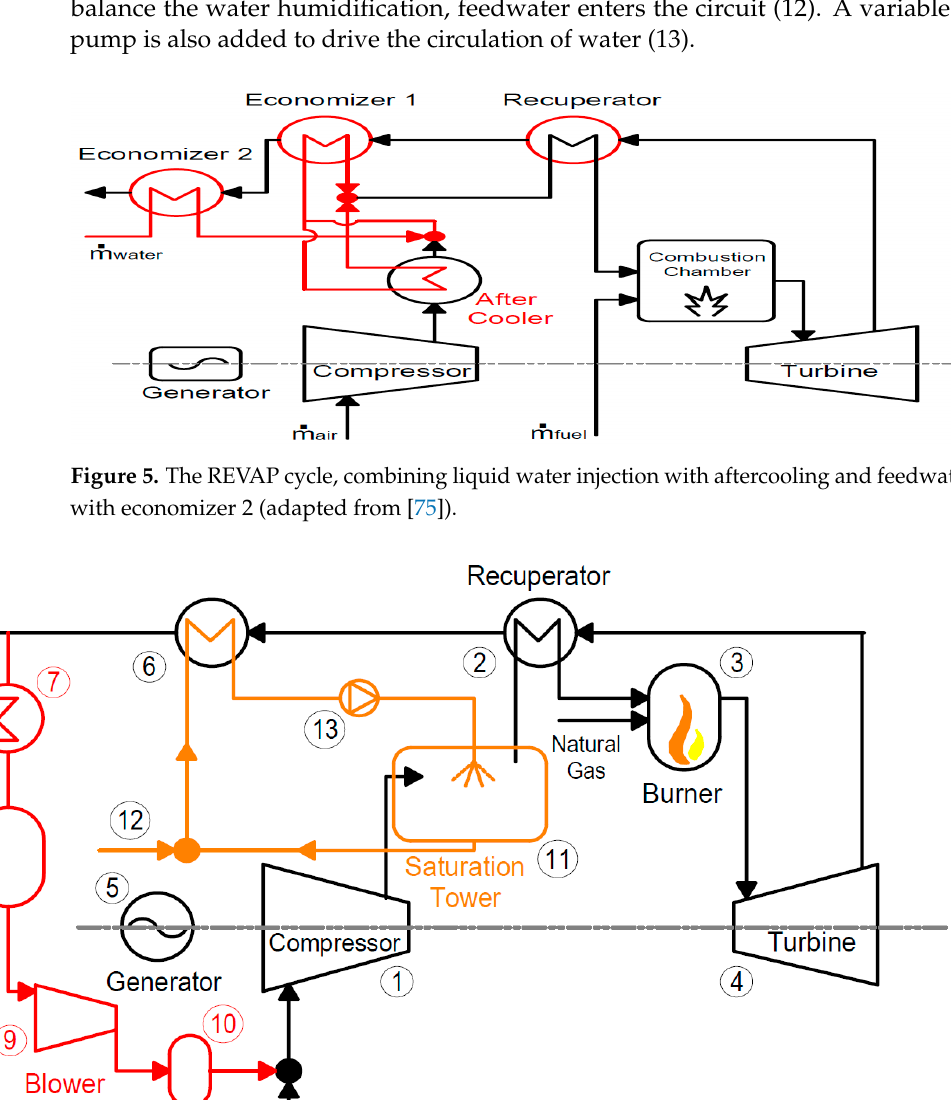
Figure 6. Conventional mGT transformed into a mHAT through the addition of the humidification sub-cycle, depicted in orange (adapted from [66]).